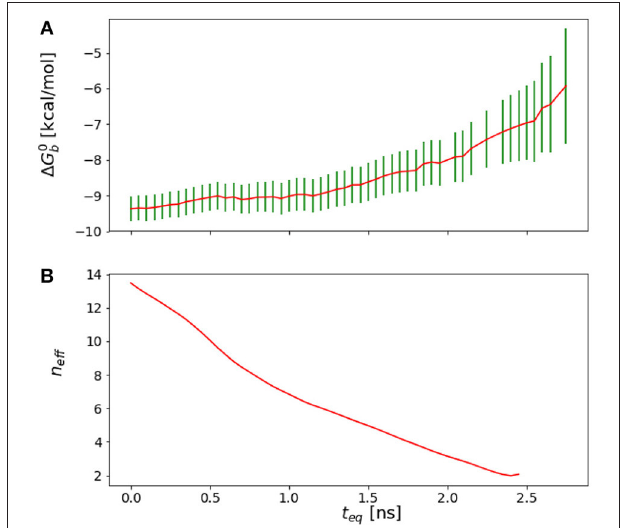
FIGURE 3 | (A) Reverse cumulative binding free energy convergence plot for the complex with peptide Mutant 4, I365A. The arrow points to the computed equilibration time. (B) Plot of the effective number of independent samples, n eff , as a function of equilibration time for the same complex. The maximum indicates the estimated equilibration time of 1.9 ns. where the autocorrelation function, C t is defined as: